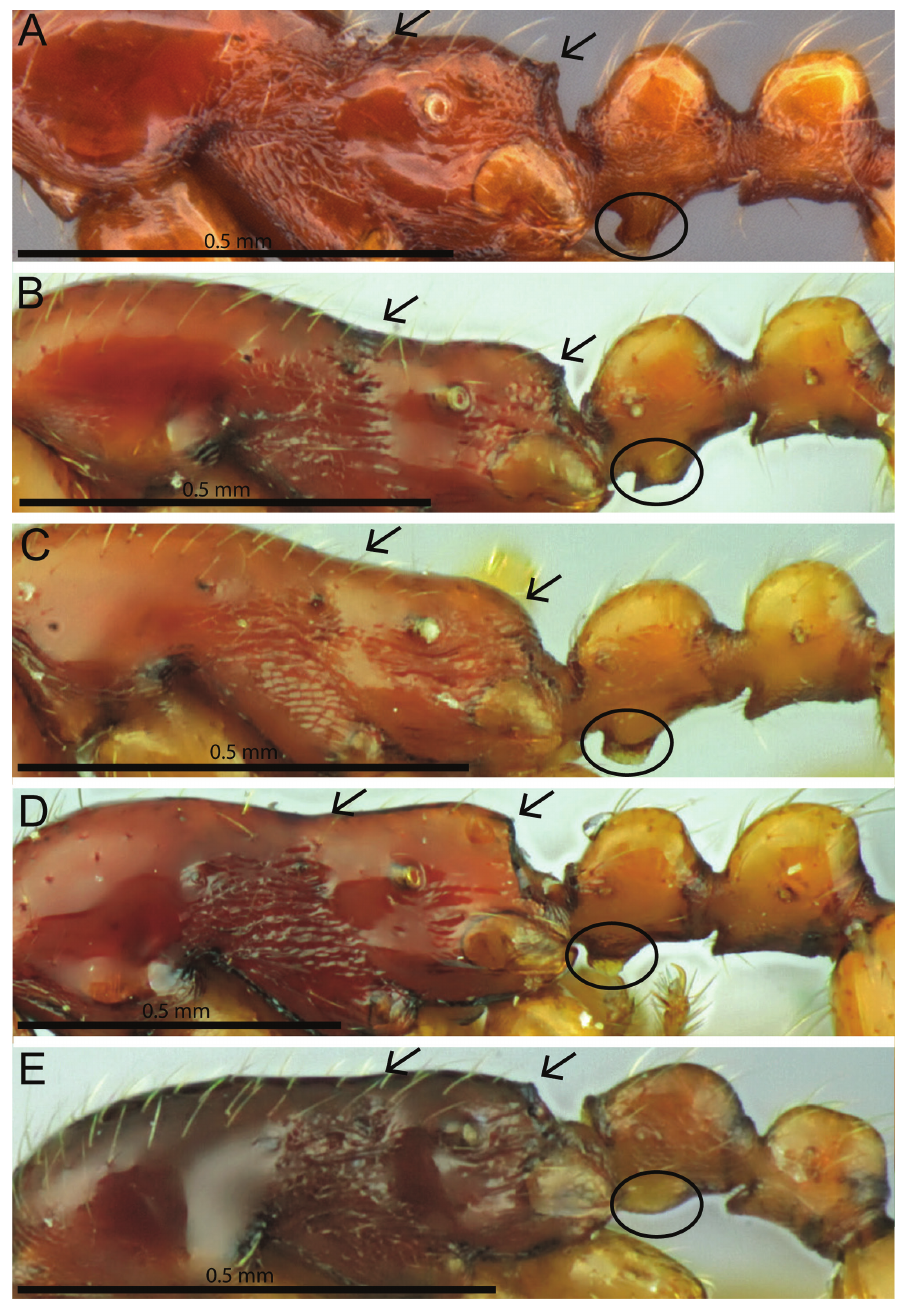
Figure 3. Mesosoma and waist segments in profile (black arrows indicate metanotal groove and propodeal junction, black ellipse subpetiolar process). A A. yangi sp. n. B A. baliensis Jaitrong & Yamane C A. longi- cephalus Jaitrong & Yamane D A. minipetiolus Jaitrong & Yamane E A. wiwatwitayai Jaitrong & Yamane. Images except figure 3A are from Jaitrong and Yamane